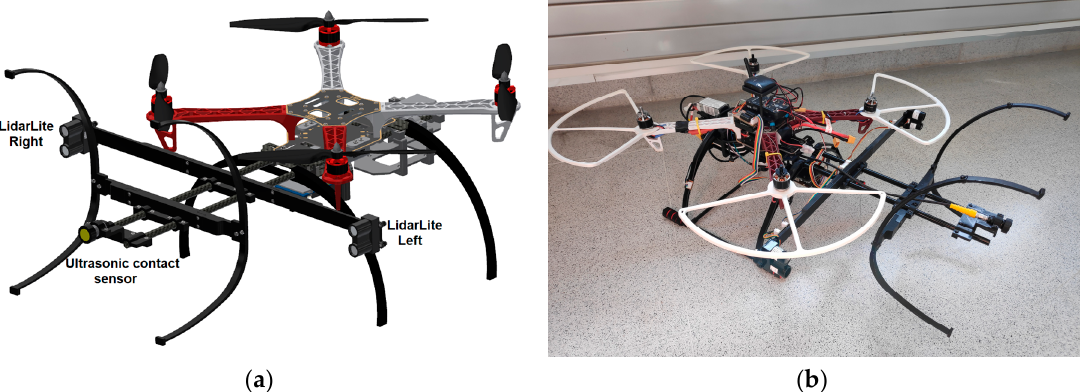
Figure 1. ( a ) Simplified CAD design of the UAV with the payload. ( b ) Payload installed in the UAV.